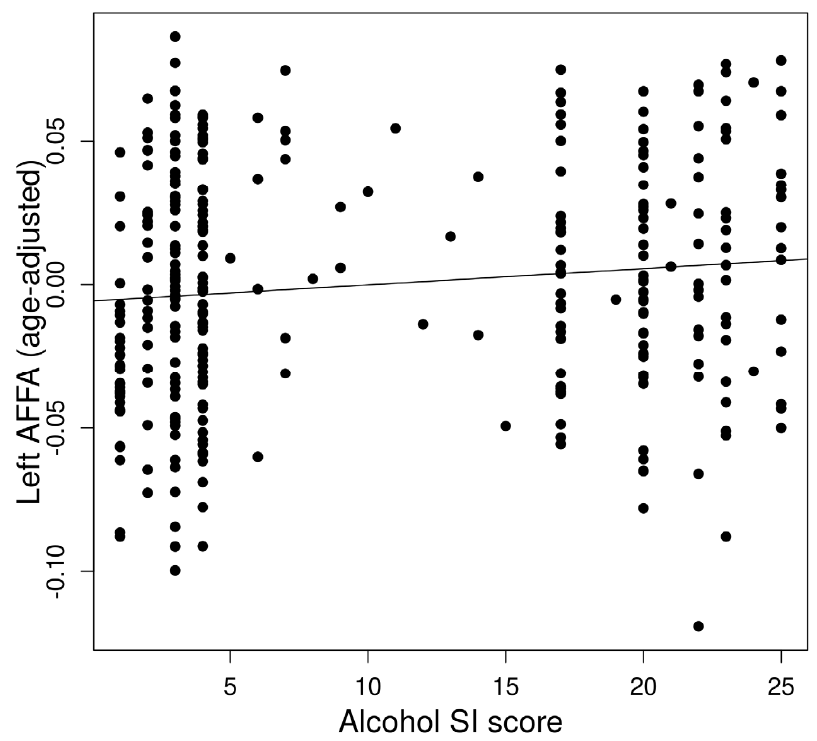
Figure 2. Association between alcohol dependence risk and left Arcuate Fasciculus FA (AFFA).